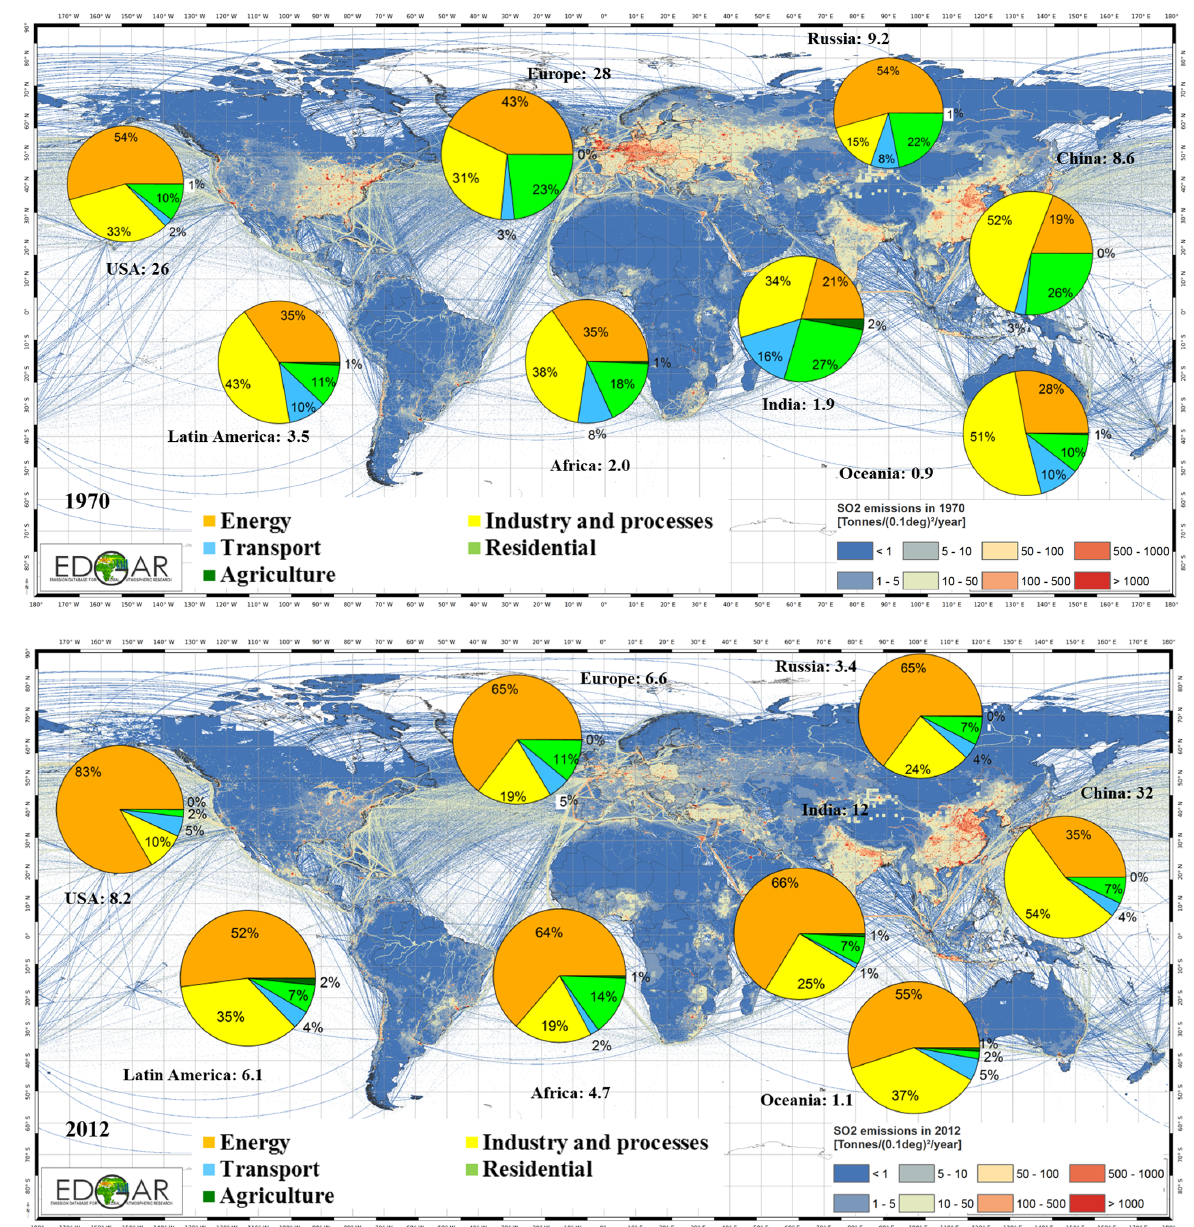
Figure 1. SO 2 emission grid maps and relative contribution of aggregated EDGAR sectors (energy, industry and processes, transport, residential, and agriculture) in world regions (pie charts) for 1970 and 2012. Total emissions (in Mtyr − 1 ) by region are also reported next to each pie